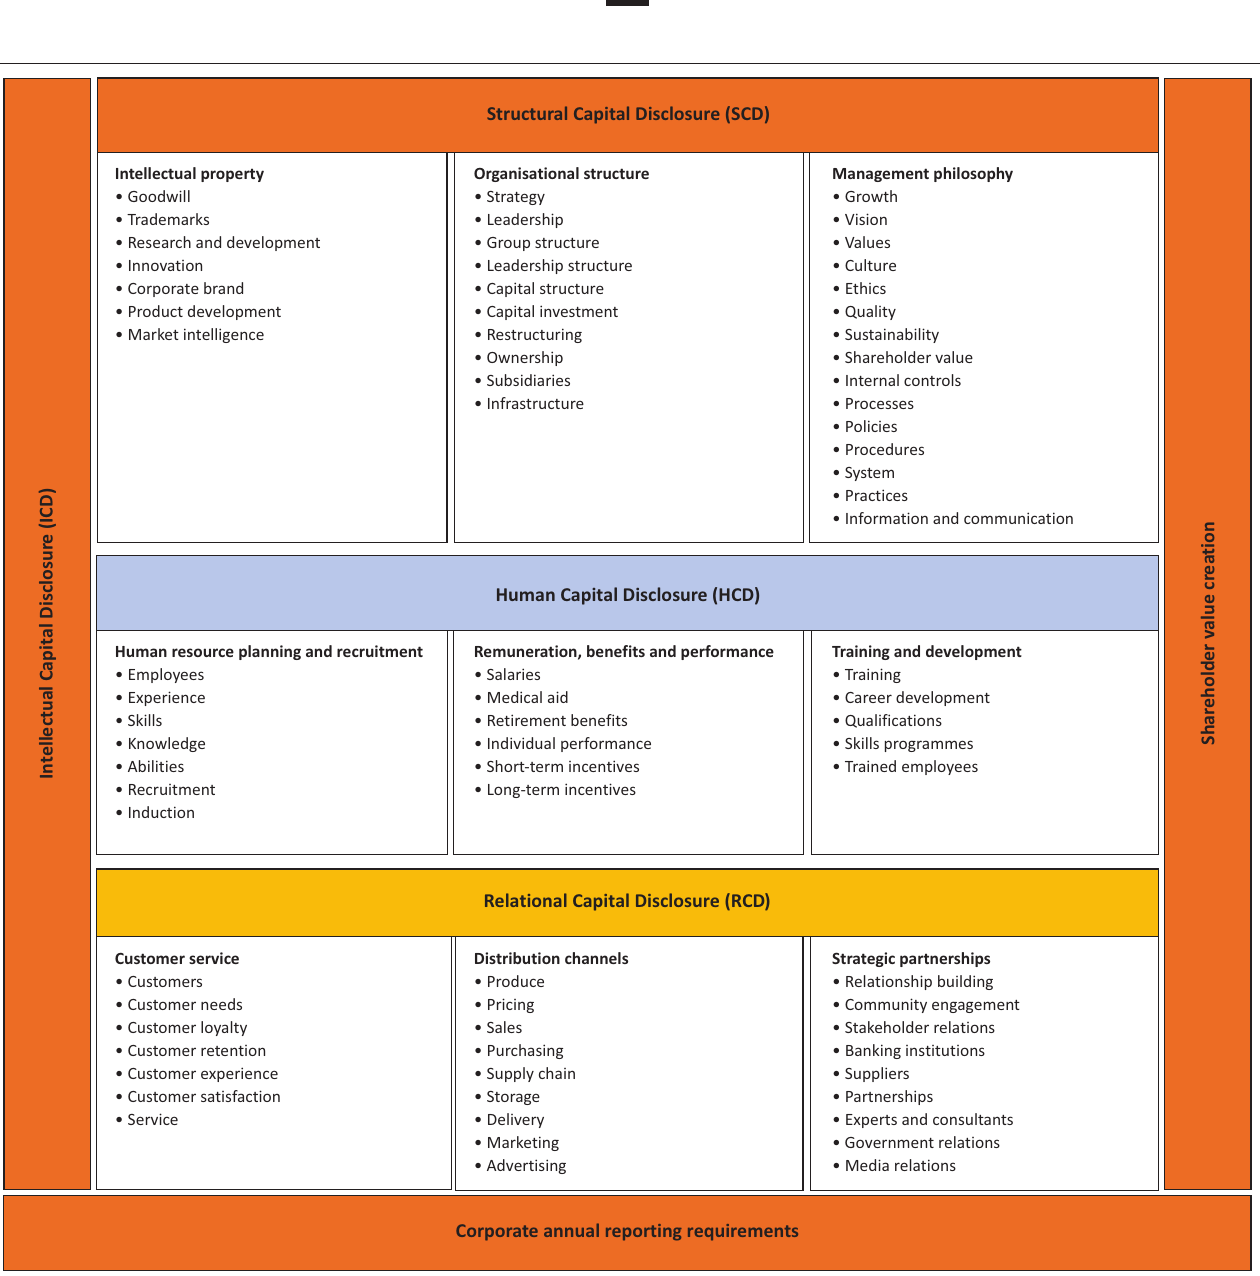
FIGURE 1: Intellectual capital disclosure measurement conceptual